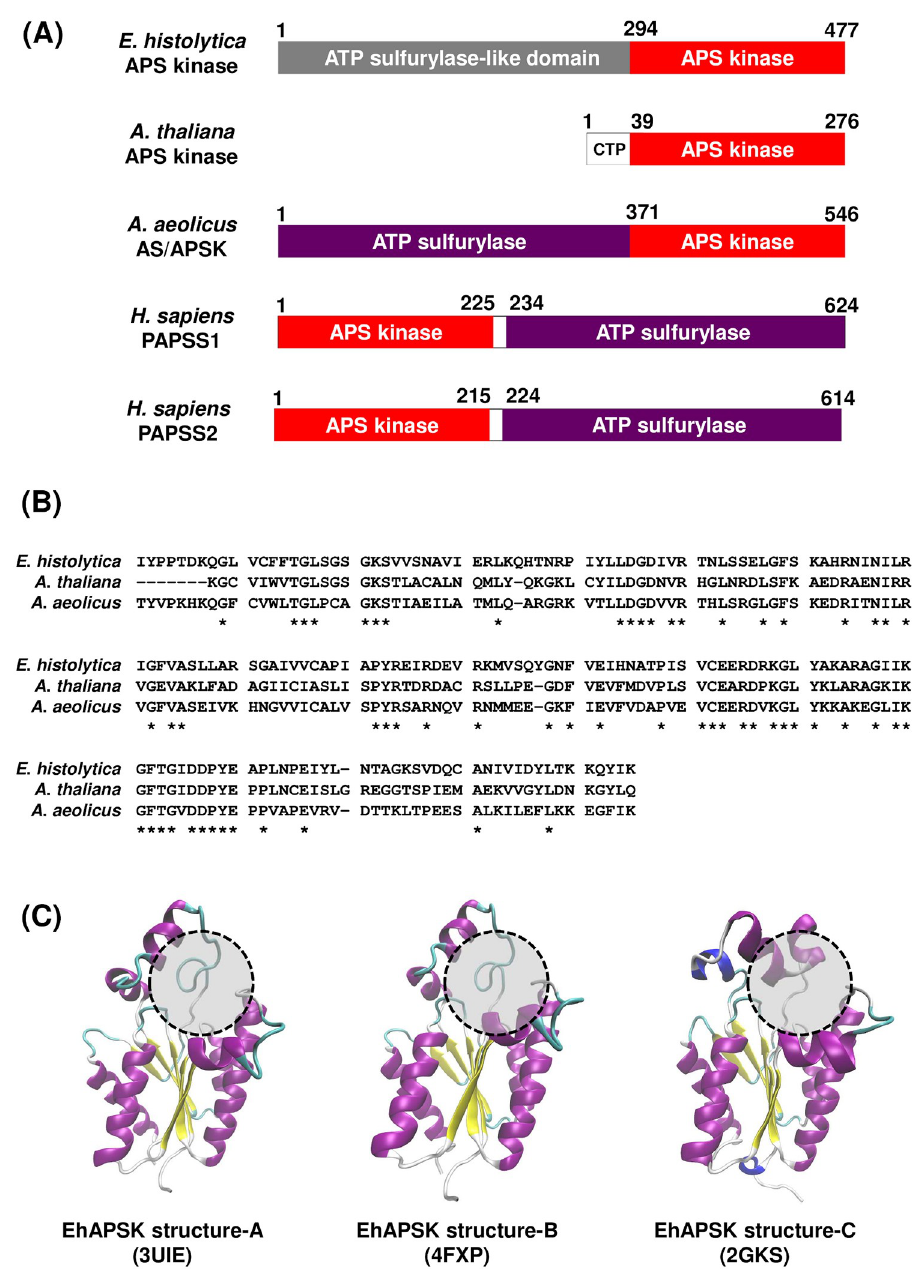
Fig 1. Prediction of the tertiary structure of the EhAPSK APSK domain. (A) Schematic illustration for the arrangement of the APS kinase and ATP sulfurylase domains. Red and purple represent APS kinase and ATP sulfurylase domains, respectively. CTP, chloroplast targeting peptides. (B) Sequence alignments of APSK domains from E . histolytica APSK, A . thaliana APSK, and A . aeolicus PAPSS, which were extracted from S1 Fig. The amino acid residues conserved among these three proteins are indicated by � . (C) Homology modeling structures of the EhAPSK APSK domain. Three different homology modeling structures, EhAPSK structure-A, -B, and -C, are shown. PDB IDs shown inside parentheses indicate the template tertiary structure used for generating each structure. The APS binding site of each structure is shown by a dashed circle.